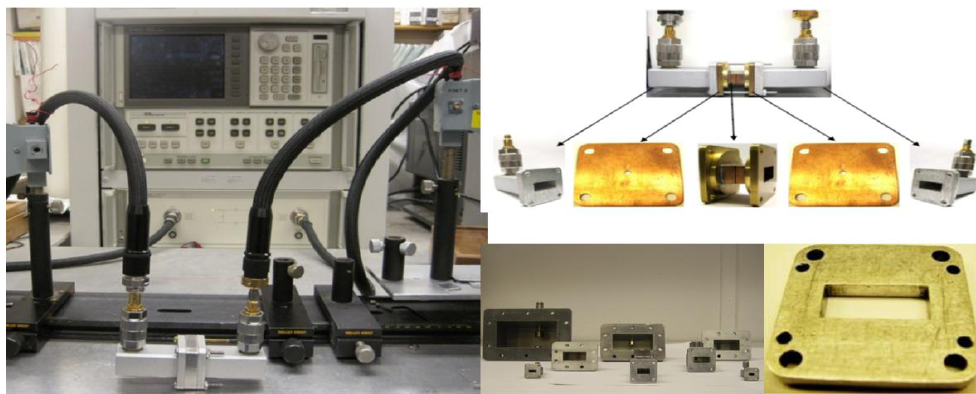
Figure 6. The in-waveguide setup using the newly designed eight waveguides and non-contact sample holder.